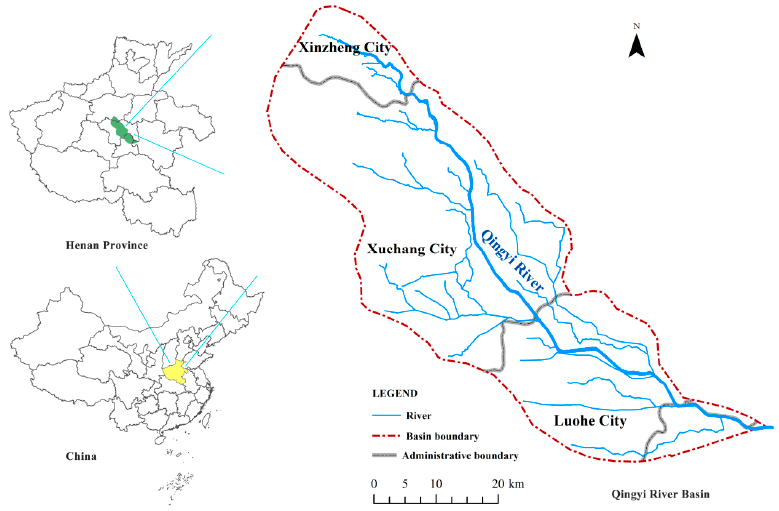
Figure 3. Location of the Qingyi River Basin, Henan Province, China. Water 2021 , 13 , x FOR PEER REVIEW